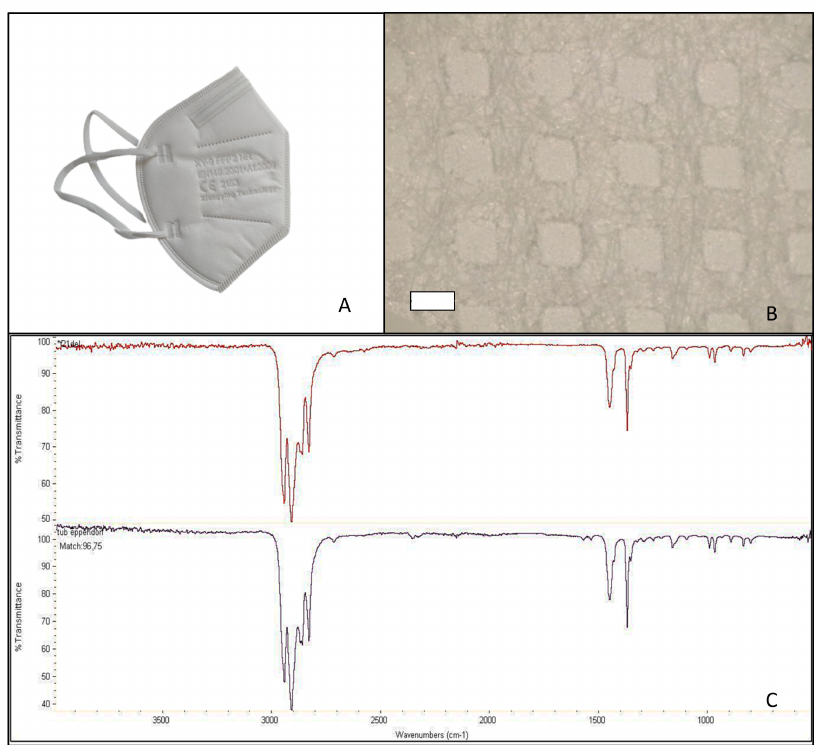
Figure 2. Facial mask FFP2 B studied ( A ); structure after disassembling in layers (500 µ m scale bar) ( B ); and mask spectrum (at the top), spectrum listed in the library (at the bottom) identifying polypropylene, atactic, 96.42% ( C ).